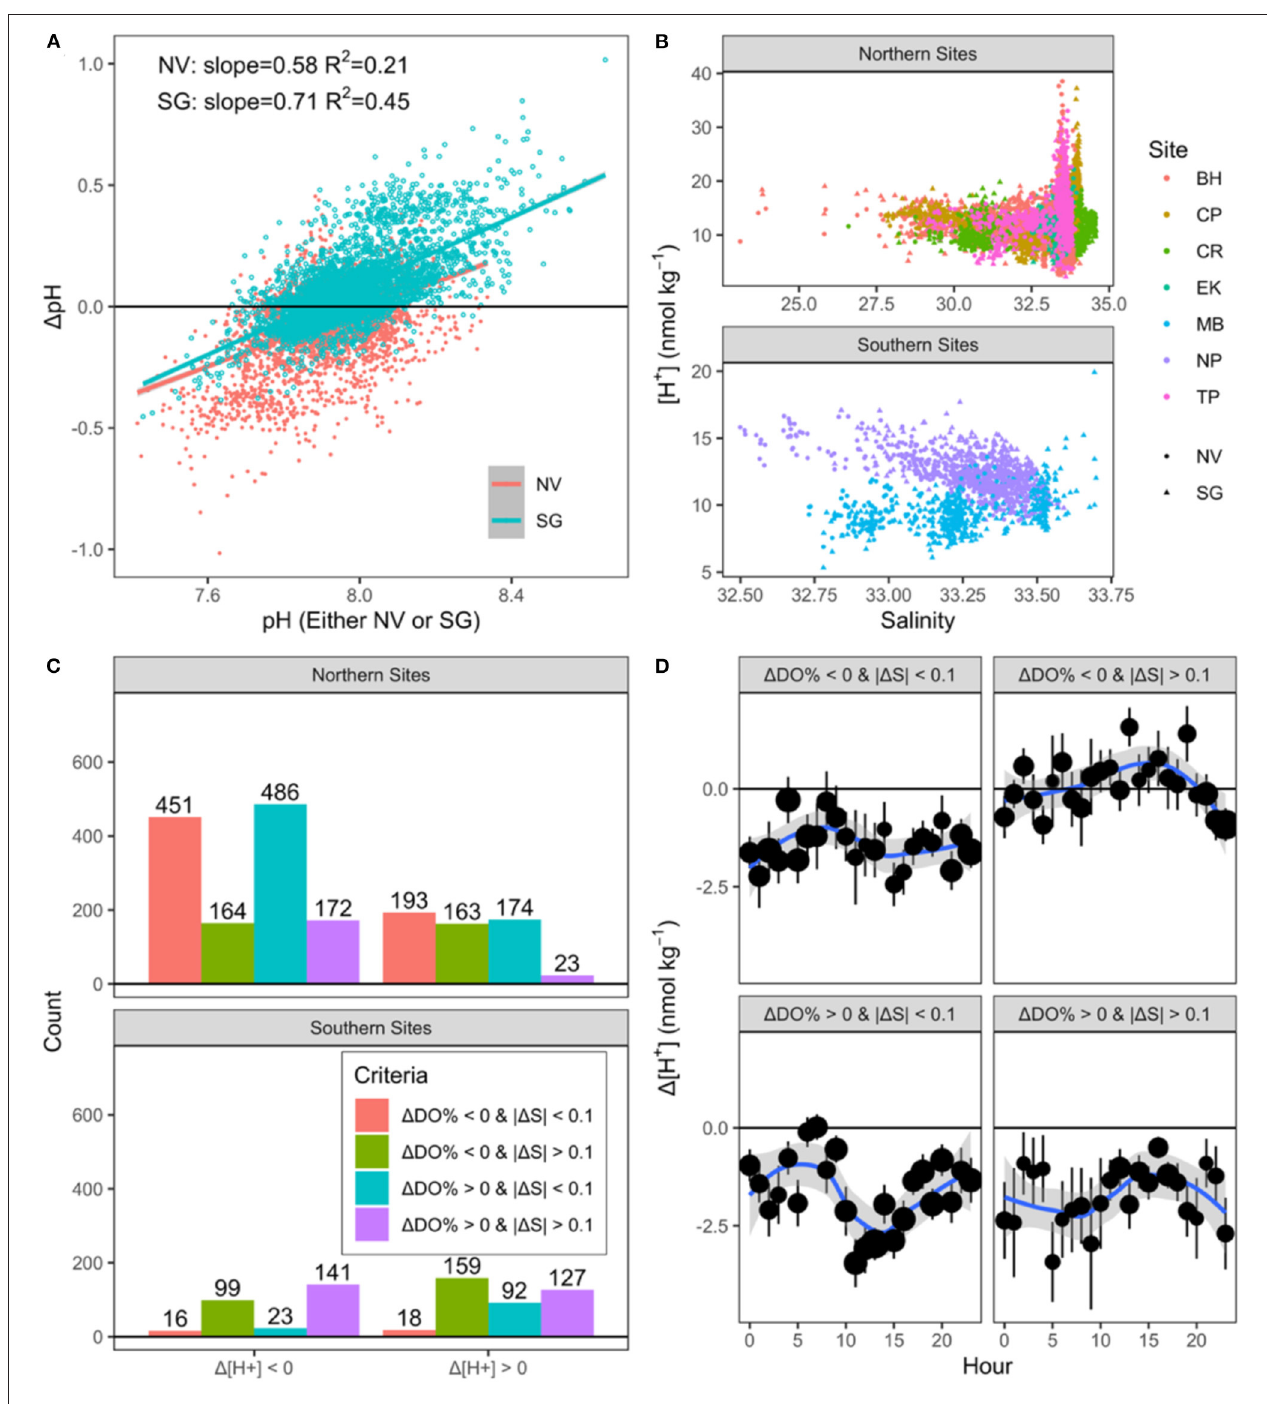
FIGURE 1 | Linear correlation ( p < 0.001) between pH and 1 pH (A) . Relationship between salinity and [H + ], separated by region and site (B) . Points in (B) are colored by site, while the shape identifies between “Seagrass” (SG) and “Non-vegetated” (NV) areas. Counts of positive and negative 1 [H + ] hourly averages, separated by region and by the threshold criteria described in the legend (C) . Hourly climatology (D) of 1 [H + ], separated by the same criteria as (C) , with point size scaled to represent sample size.